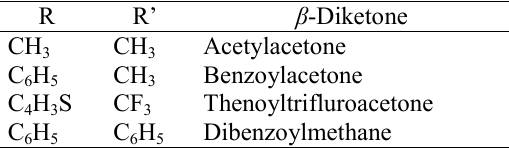
The elemental analysis (Table 1) of complexes show 1:1 metal to ligand stoichiometry. The molar conductivity of dioxmolybdenum(VI) complexes in dimethylformamide showed values of Λ between 125-140 ohm -1 cm 2 mol -1 which indicate their electrolytic M